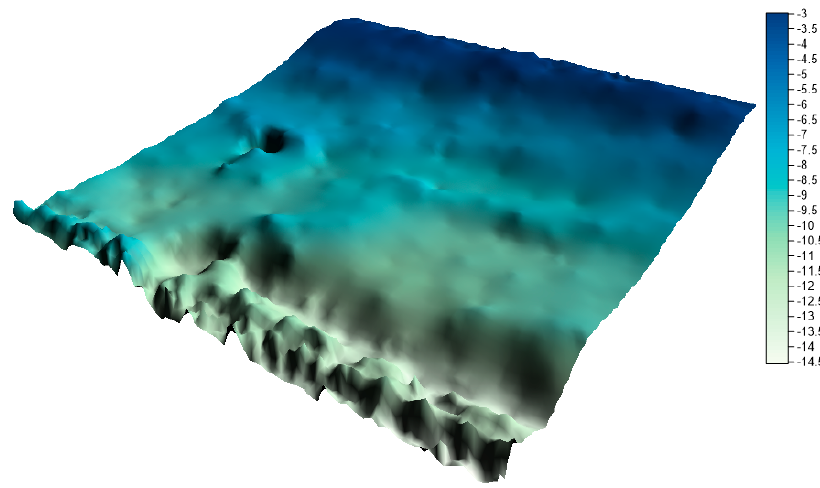
Figure 13. Surface obtained by integrated dataset no. 3 for the LNG port area.